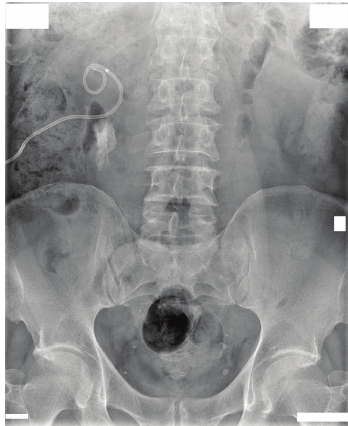
Figure 3: Plain X-ray image of the urinary tract after eight extracor- poreal shock wave lithotripsy sessions shows partial disintegration of the stone in the right renal pelvis.